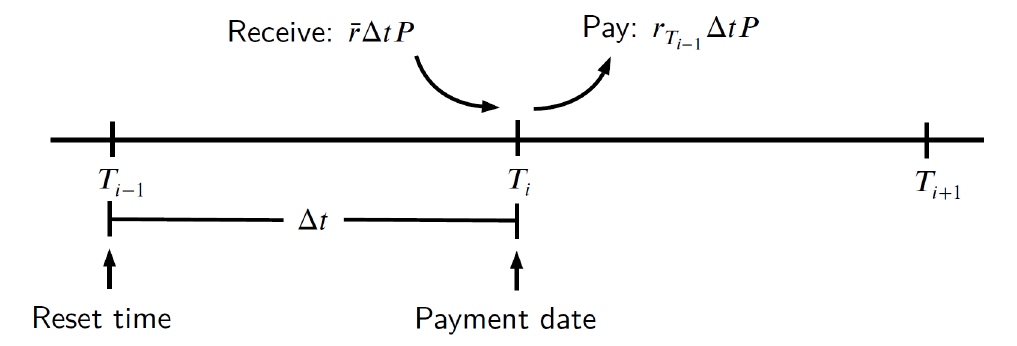
Figure 6. Cash flow of a vanilla swap at time T i